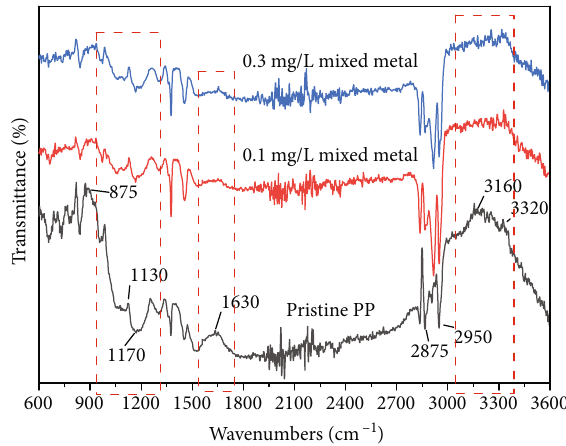
Figure 9: FTIR diagram of PP after adsorption of heavy metals with di ff erent concentrations ( C e = 0 : 7 mg · L -1 , V = 20 mL, temperature at 298K).